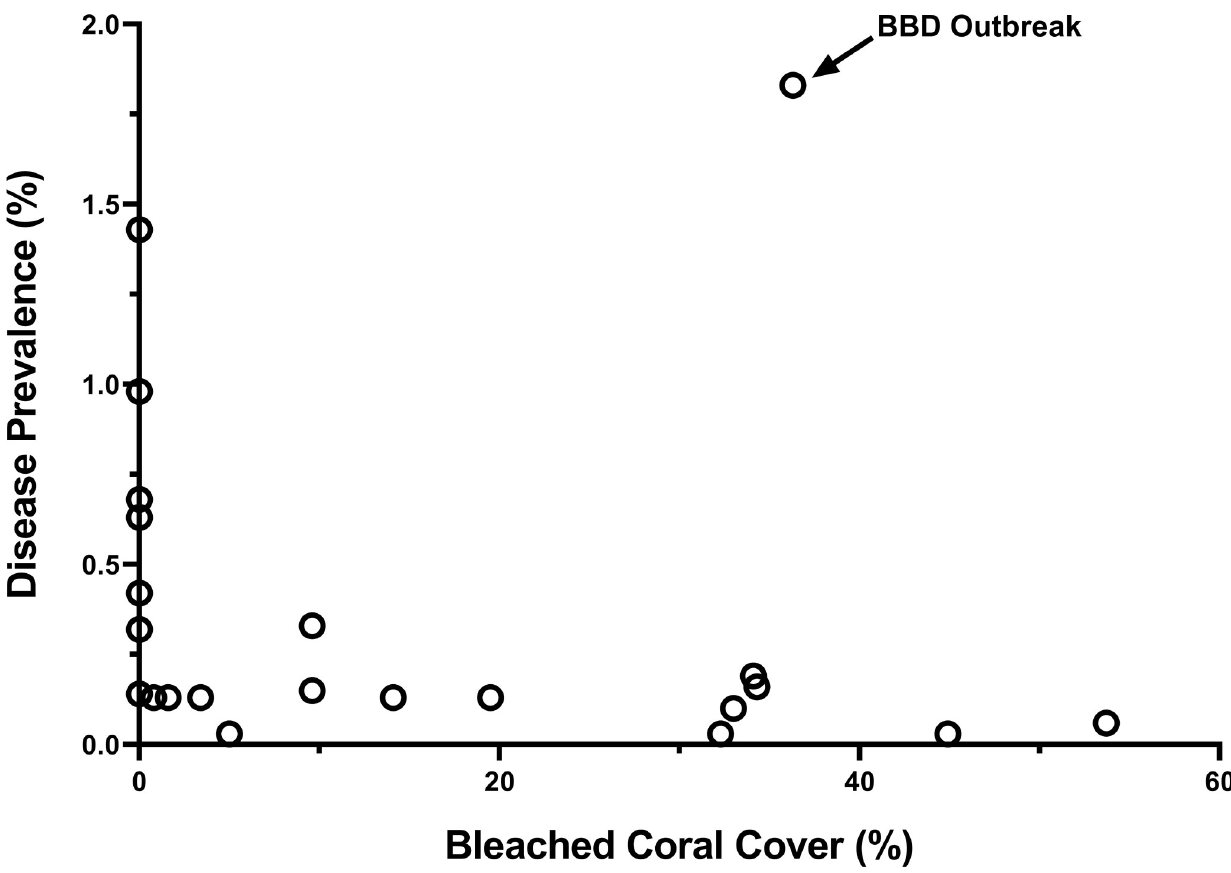
Fig 9. Relationship between coral disease and level of bleaching for 22 sites surveyed in 2015 along the Red Sea coast of Saudi Arabia.